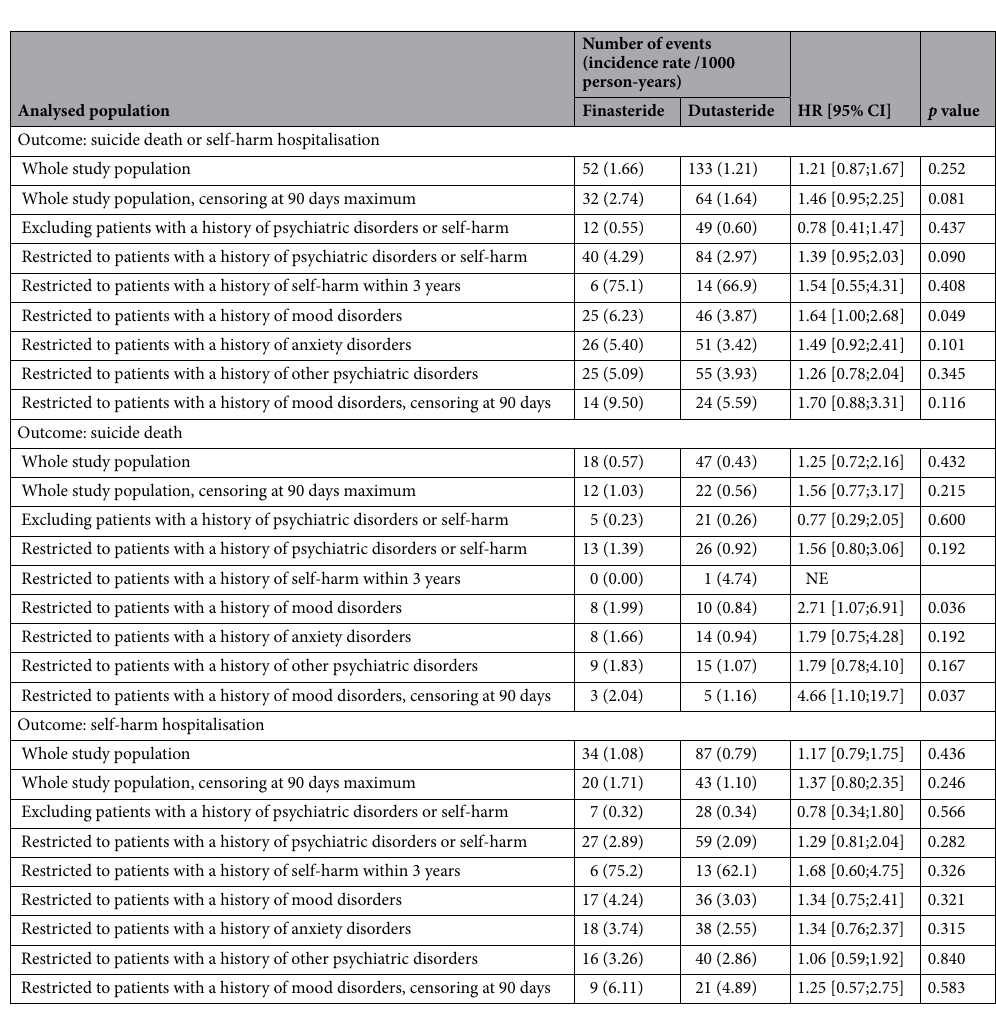
Table 2. Risk of suicide death and self-harm hospitalisation (considered separately) associated with finasteride compared to that with dutasteride (IPTW adjusted analyses). Cox proportional hazards models controlled by IPTW for the following potential confounders: age, year of treatment initiation, pre-existing prostatic and psychiatric conditions and treatments, comorbidities used in the Charlson index. CI: confidence interval. HR: hazard ratio. IPTW: inverse probability of treatment weighting. NE: not